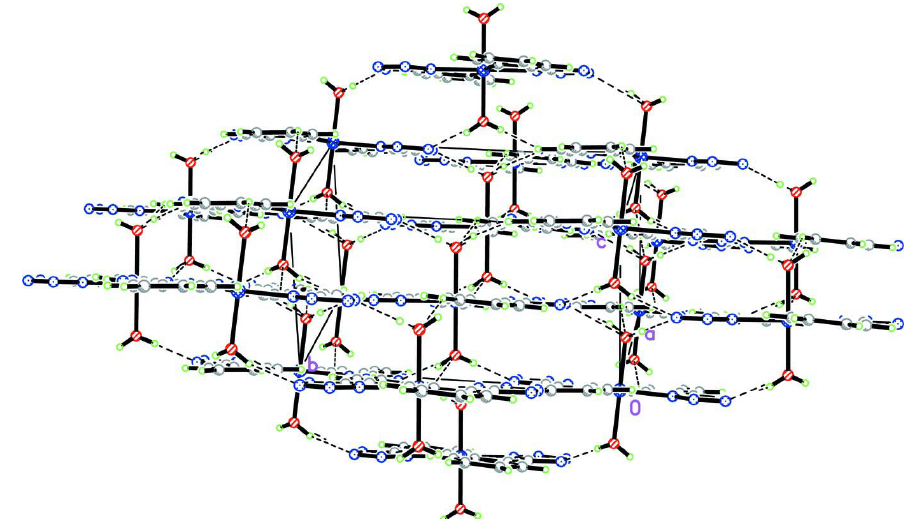
Figure 2 Packing diagram of (I) showing the hydrogen bond